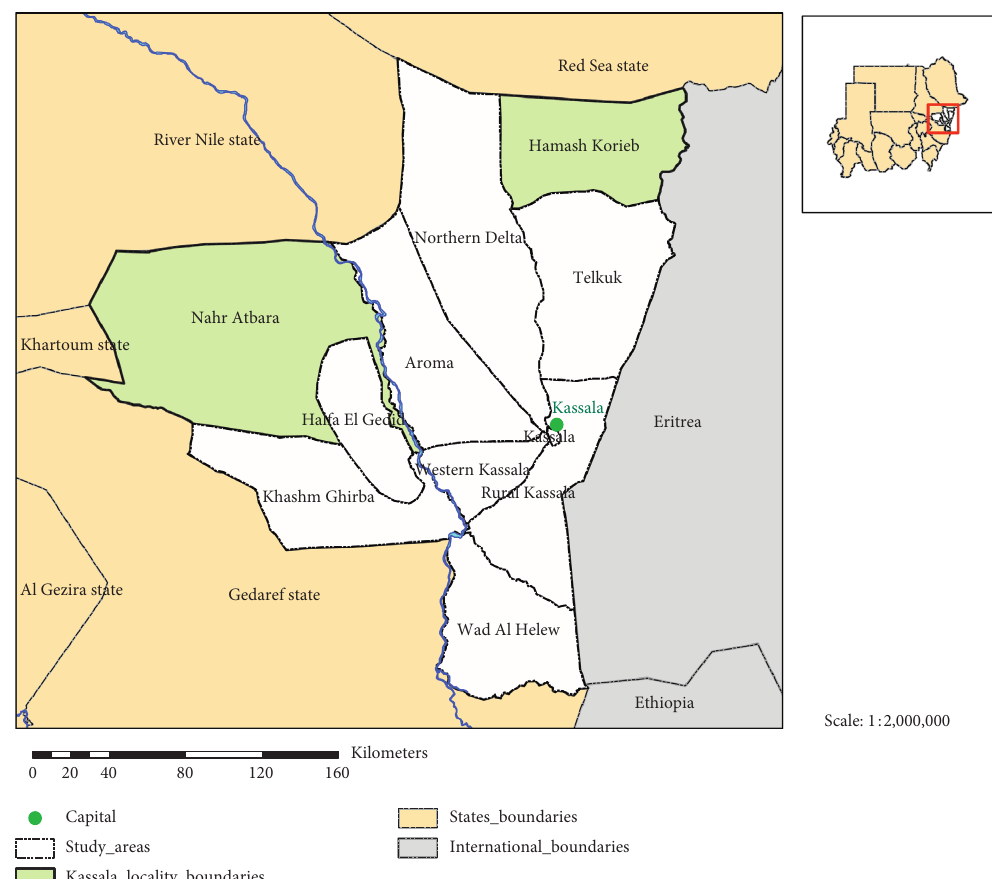
Figure 1: Map of Kassala state showing the locations where tissue specimens and sera samples were collected. The study area is located between longitude 14–17 ° N and latitude 34–37 °